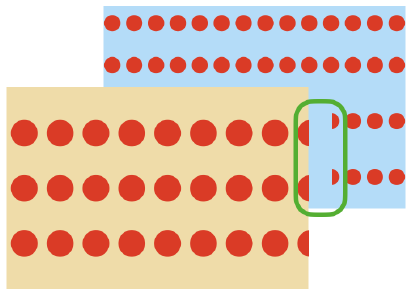
Figure 5. Unwanted points returned by the VLP-16 LiDAR. (a) Object sensed by the LiDAR. (b) Point cloud (side view) returned by the LiDAR. (c) Unwanted points in red. (d) Expected filtered result.